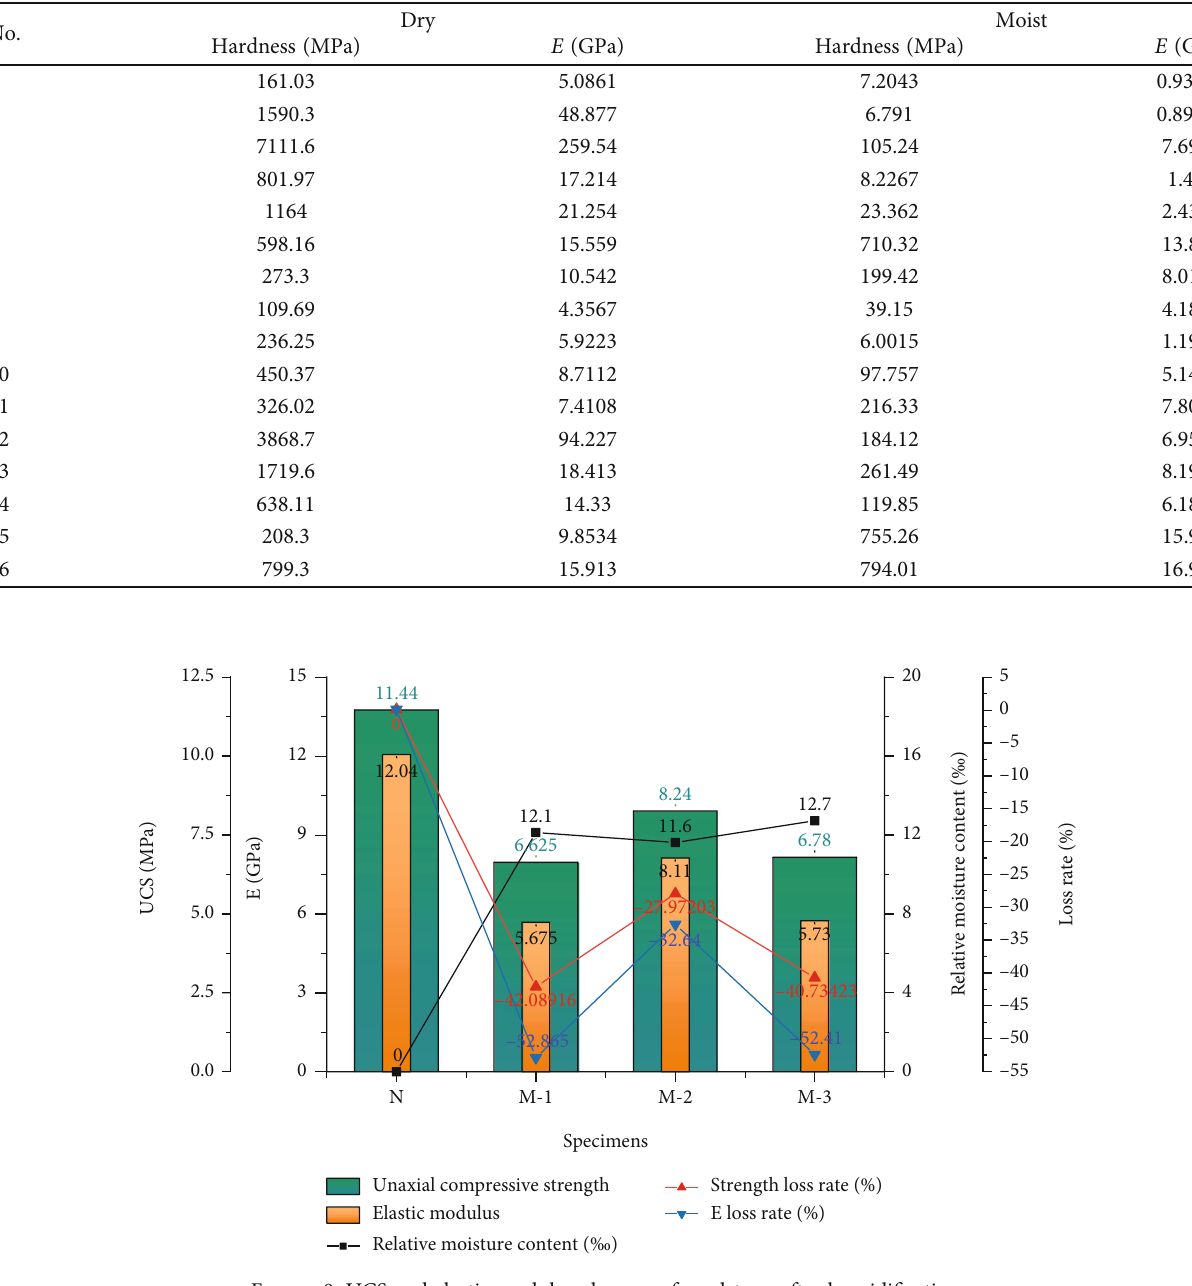
Figure 8: UCS and elastic modulus changes of mudstone after humidi fi cation.